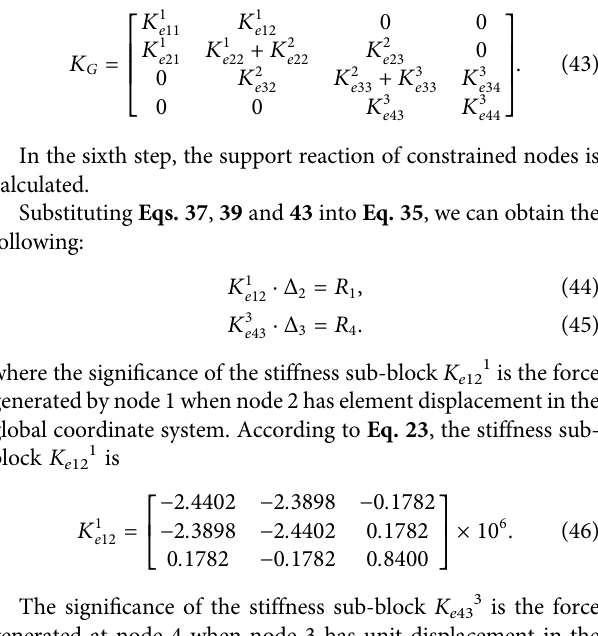
FIGURE 7 | Frame structure deformation